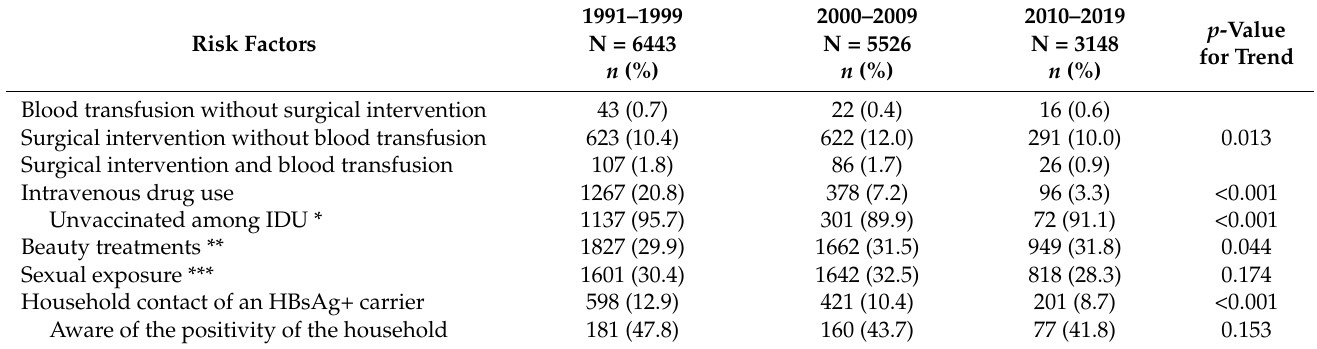
Table 2. Frequency (%) of non-mutually exclusive risk factors reported by acute hepatitis B cases according to decade. SEIEVA 1991–2019. (Information was missing in some cases).